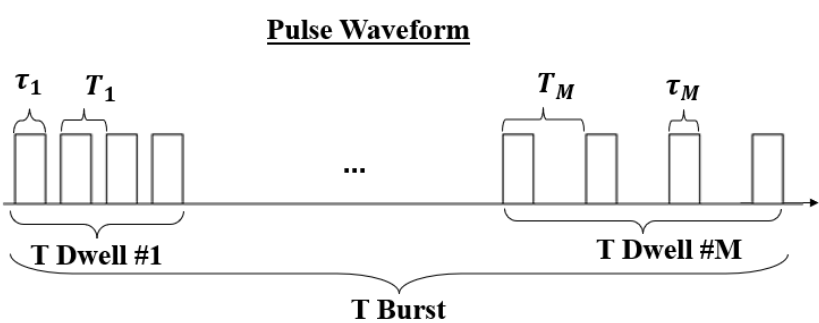
Figure 3. Radar burst waveform. The waveform characteristics are shown in Table